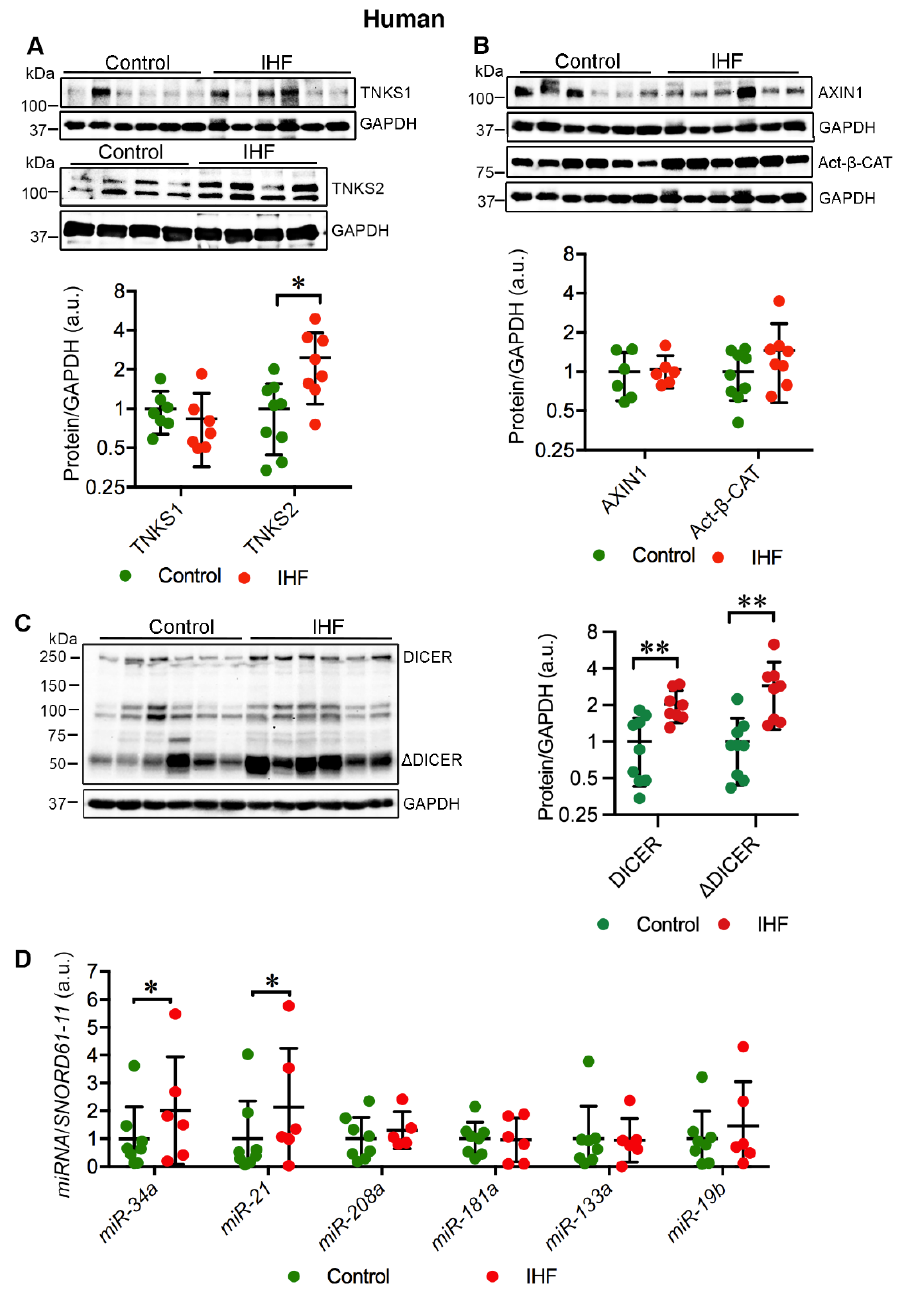
Figure 1. Cardiac TNKS2 and DICER are stabilized in ischemic heart failure (IHF) patients. ( A ) Rep- resentative immunoblots of TNKS1 and TNKS2 in the left ventricle (LV) of IHF and healthy controls. ( B ) Representative immunoblots of AXIN1 and active β -catenin (Act- β -CAT) in the LV of IHF and healthy controls. ( C ) Representative immunoblots of DICER and truncated DICER ( ∆ DICER) in the LV of IHF and healthy controls. The graphs represent quantifications of three replicate blots for the indicated proteins relative to GAPDH. The results are presented as fold change compared to controls. The blurry or oversaturated bands were excluded from the quantification. Controls: TNKS1, n = 7; TNKS2, n = 9; AXIN1, n = 6; Act- β -CAT, n = 9; DICER, n = 9; ∆ DICER, n = 9; IHF: TNKS1, n = 7; TNKS2, n = 8; AXIN1, n = 6; Act- β -CAT, n = 8; DICER, n = 8; ∆ DICER, n = 8. ( D ) qRT-PCR analysis of miRNA expression in the LV of IHF patients ( n = 6) and healthy controls ( n = 8). Data are presented as mean ± SD. Two-sample t -test: * p < 0.05, ** p <